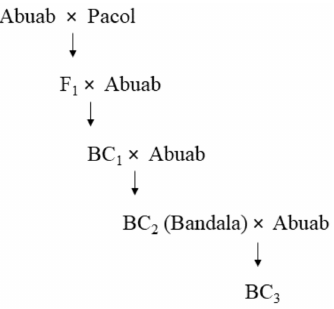
Figure 1. Schematic diagram of how backcrosses were generated. Abuab serves as a female parent recipient at the original stage of crossing (F 0 ); Pacol, as male. In the succeeding backcrosses, Abuab serves as the recurring pollen donor, the source of high fiber quality alleles. Note that BC 2 is nicknamed